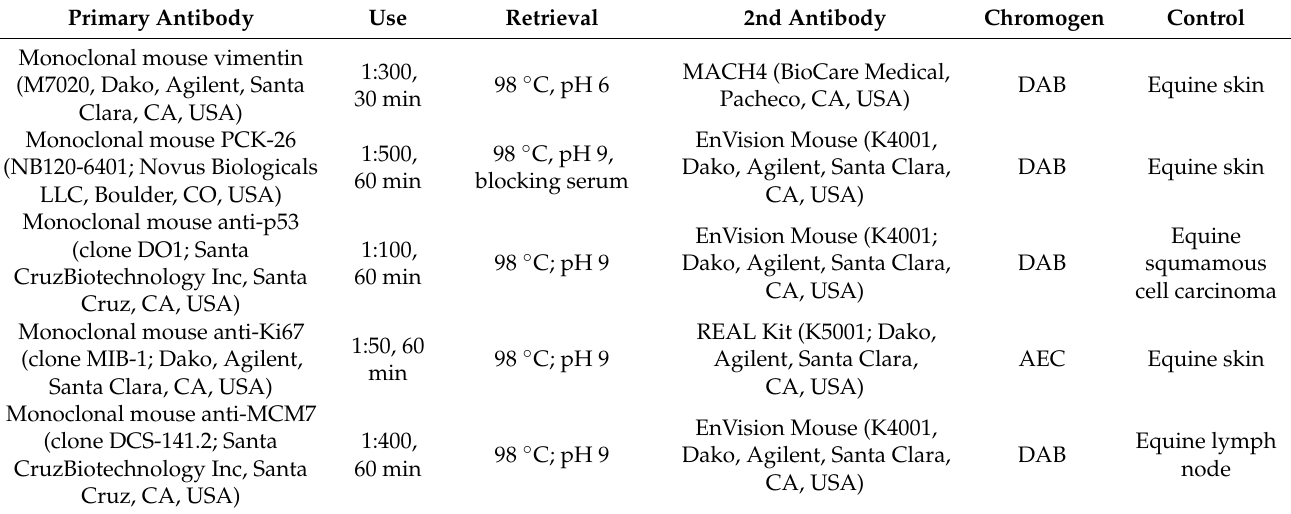
Table 1. Immunohistochemistry (IHC) antibody